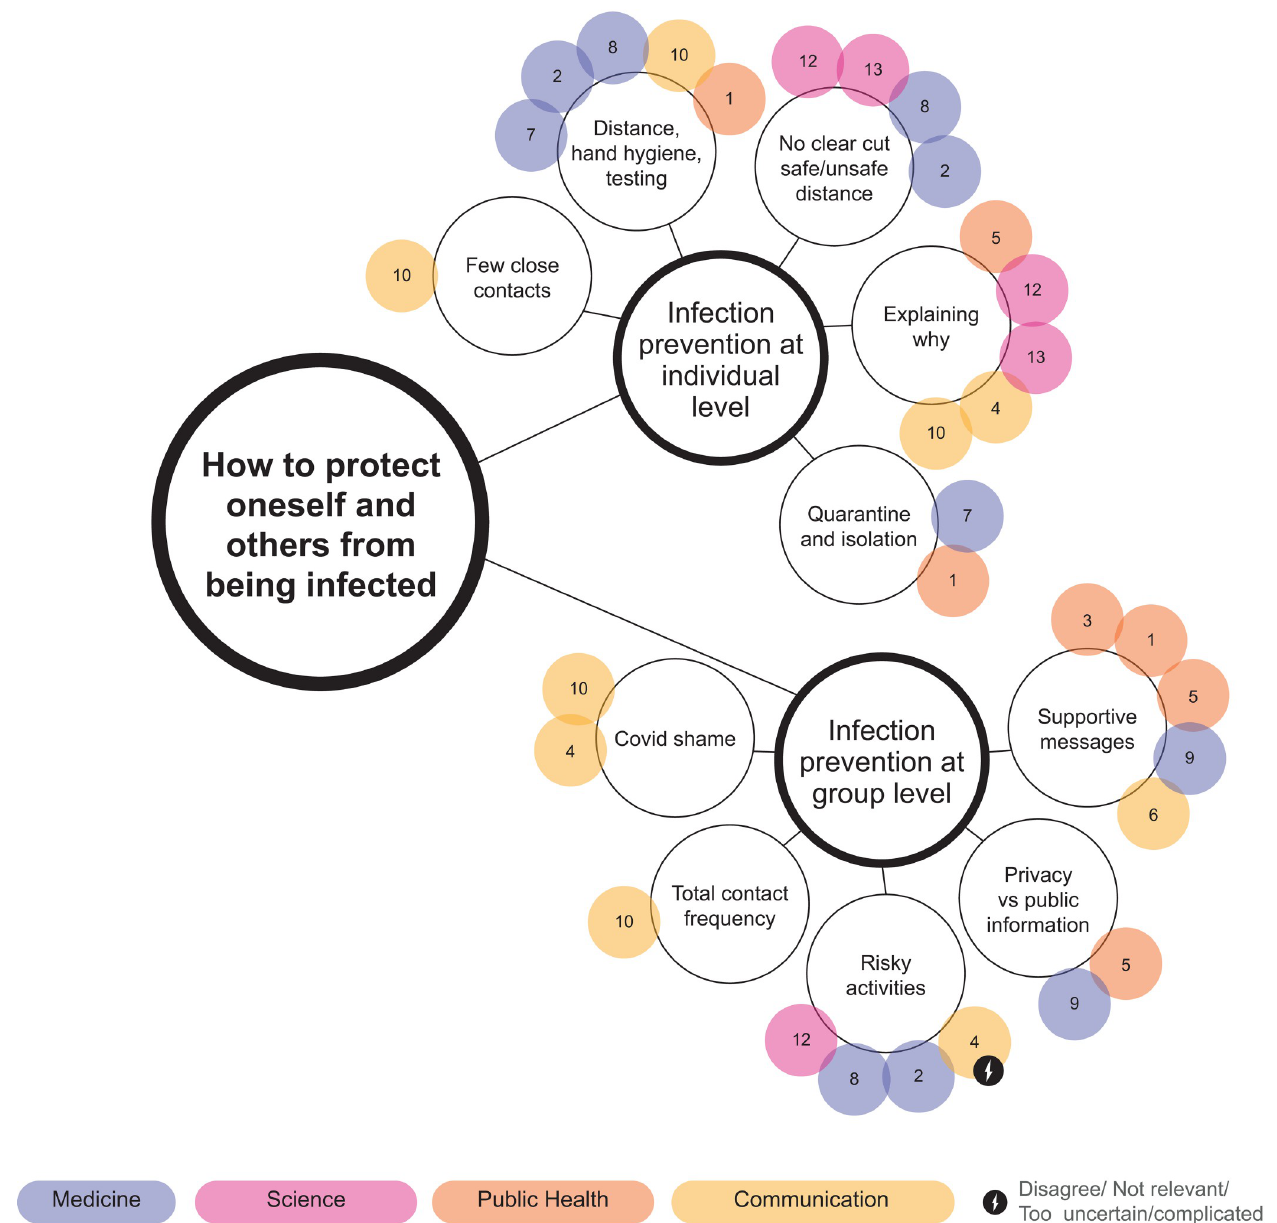
Fig 2. Bubble chart representation of information from interviews relating to the theme ‘How to protect oneself and others from being infected’.